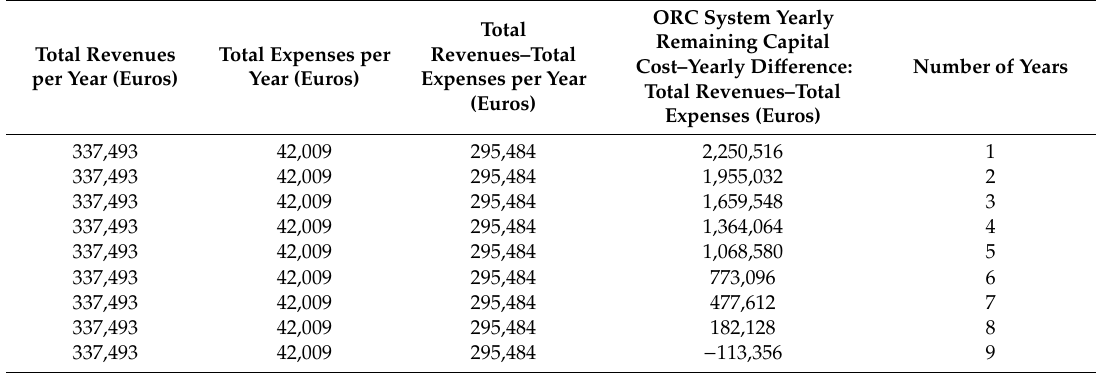
Table 10. Analysis of the payback period of the proposed regenerative dual-loop ORC for its onboard operation on the general support